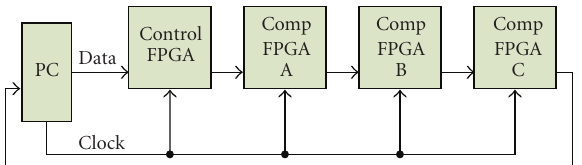
Figure 7: JTAG chain for reconfiguration of the FPGAs on an FLC. In JTAG reconfiguration mode, each FPGA can be selected separately for a reconfiguration, whereas deselected FPGAs remain in normal operation mode. Reconfiguration of di ff erent FPGAs within the chain is